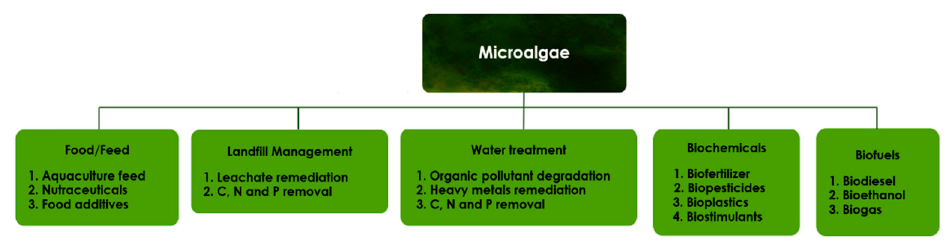
Figure 1. Uses and products of microalgae.